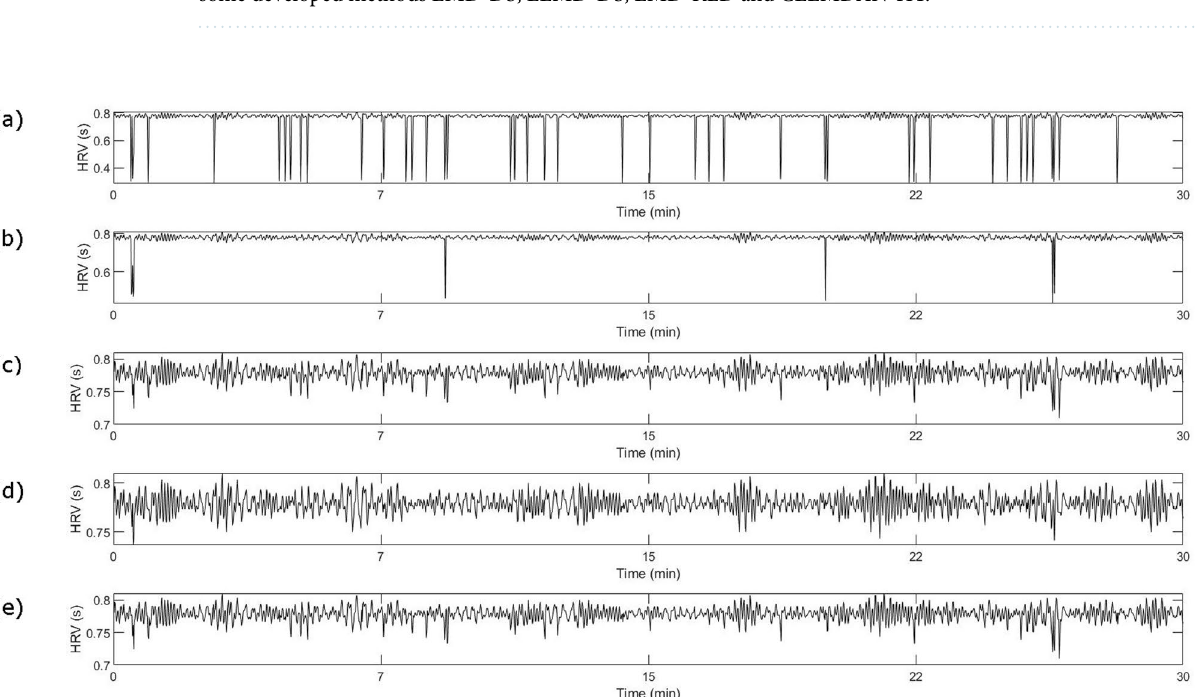
Table 1. RMSE performance values for comparative analysis of the proposed CEEMDAN-WD method versus some developed methods EMD-DS, EEMD-DS, EMD-KLD and CEEMDAN-HT.